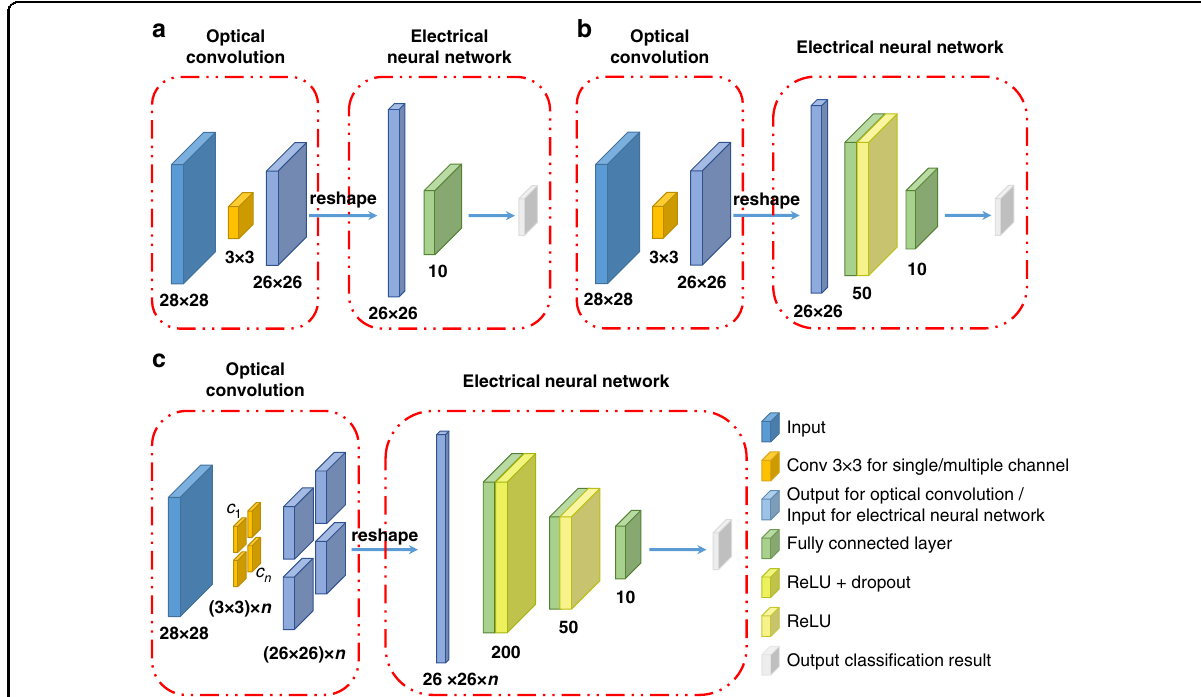
Fig. 5 Network architecture for MNIST handwritten digit recognition. a Network architecture of a single-kernel convolution neural network based on 1 FC layer. b Network architecture of a single-kernel convolution neural network based on 2 FC layers. c Network architecture of multiple- kernel convolution neural network. The networks are divided into two parts, and the optical convolution is completed in the optical domain, without calculation and energy